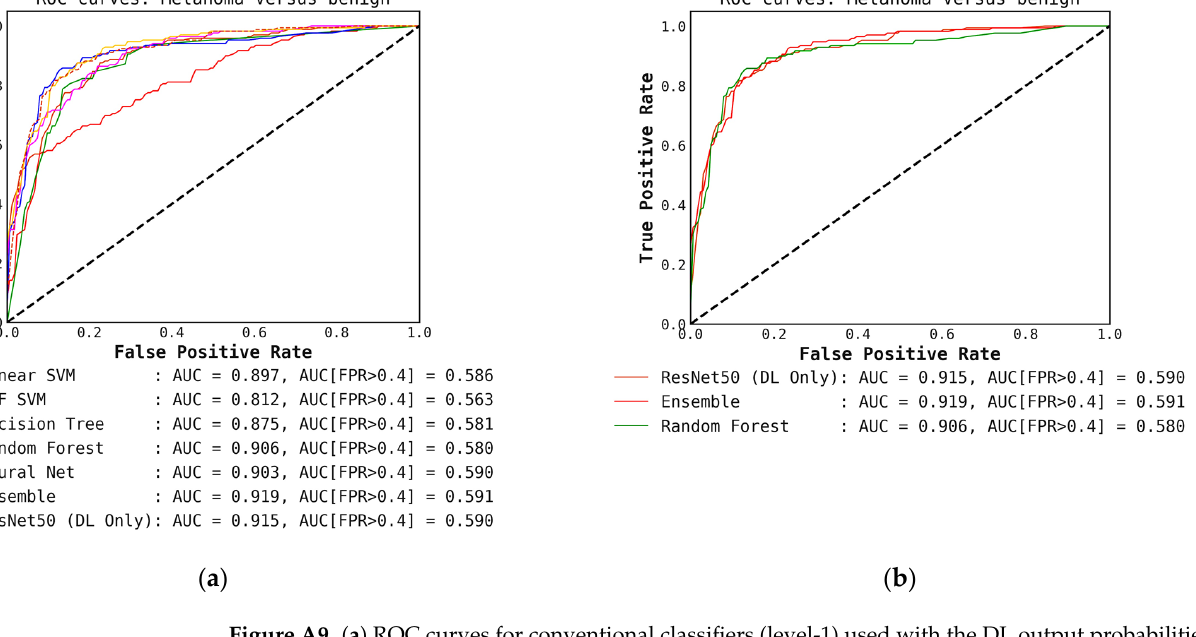
Figure A9. ( a ) ROC curves for conventional classifiers (level-1) used with the DL output probabilities from the ResNet50 (level-0) model and the hand-crafted features (cascade generalization); ( b ) Figure showing ROC curves only for the ResNet50 (level-0) model, the ensemble of conventional classifiers, and the best conventional level-1 classifier using the ResNet50 probability outputs. The AUC and the AUC for FPR higher than 0.4 are both presented for comparison. All values are rounded to three significant digits. Table A2. Table shows the 20 most important features based on the mean accuracy decrease after feature permutation. The scores are the averaged mean importance scores of all conventional classifiers without cascade generalization. Note that objects are non-overlapping distinct contours (blobs) in the irregular network binary mask generated by the segmentation model.